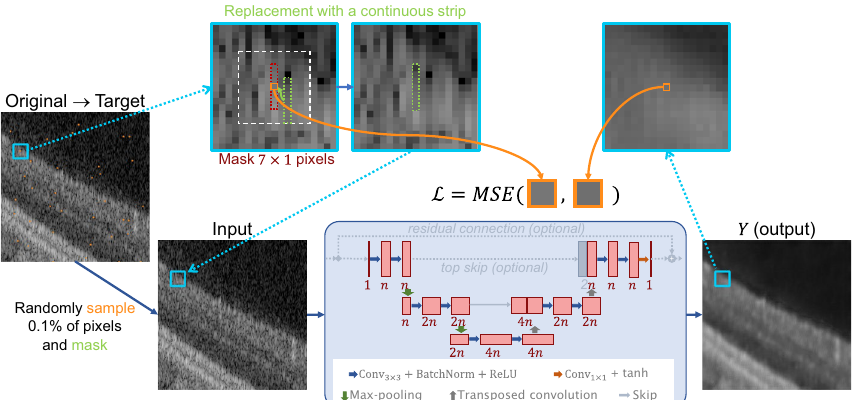
Figure 2. Proposed network architecture and training principle. Based on structured Noise2Void 27 , masking is adjusted such that neighbors are replaced together with center pixels. The principle is illustrated only for a single of multiple masked pixels. The network is a U-Net 30 with no residual and top-level skip-connections. To control the complexity of the network, and therefore to set a trade-off between speed and complexity, channels n of the individual convolution layers can be